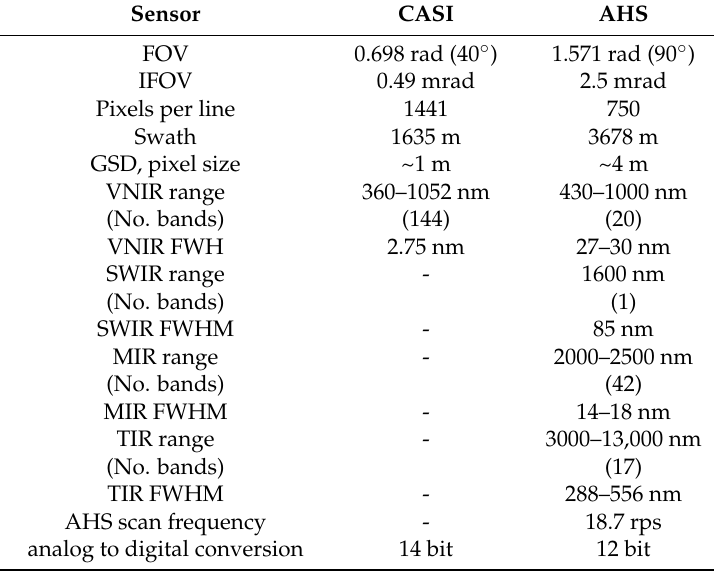
Table 2. Technical characteristics of hyperspectral sensors used for S. densiflora